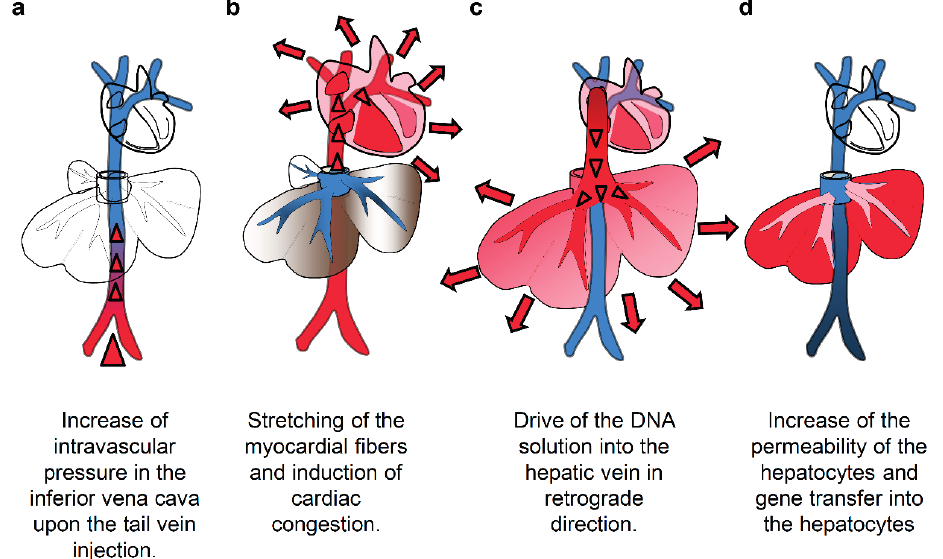
Figure 1. Mechanism of hydrodynamics-based delivery to the mouse liver. ( a ) The intravascular pressure in the inferior vena cava increases upon the tail vein injection of the solution; ( b ) induction of cardiac congestion and accumulation of the solution in the inferior vena cava; ( c ) flow of the injected solution into the liver in retrograde and pushing blood preexistent toward portal side; ( d ) pressure-mediated increase of the membrane permeability and transfer of gene into